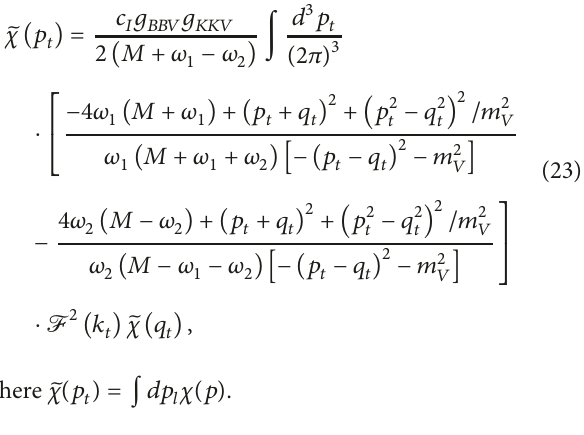
In Eq. (22) there are poles in −𝜆 1 𝑀−𝜔 1 −𝑖𝜖 , −𝜆 1 𝑀+𝜔 1 −𝑖𝜖 , 𝜆 𝑀+𝜔 −𝑖𝜖 , and 𝜆 𝑀−𝜔 +𝑖𝜖 . By choosing the 2 2 2 2